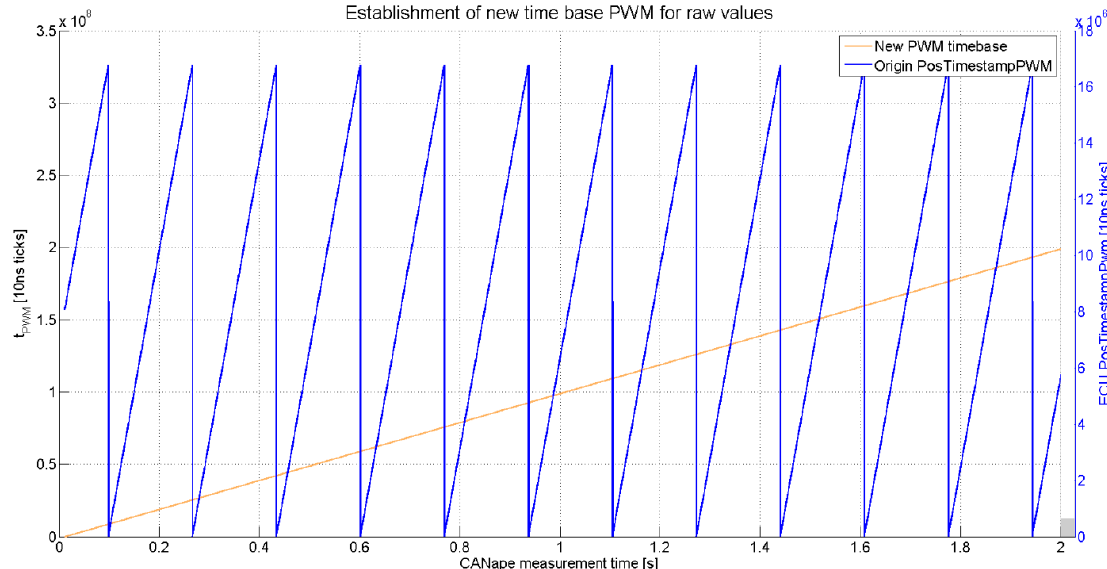
Figure 14. Exemplary original counter variable PosTimestampPWM (blue) and wrap-around removed time base for further evaluation over the whole measurement recording time ( New PWM timebase ). It can be seen that the variable PosTimestampPWM has a certain starting time due to the booting of the µ C and the wrap-around, caused by the overflow of the counting process. The variable PosTimestampDSADC evince the same behavior.